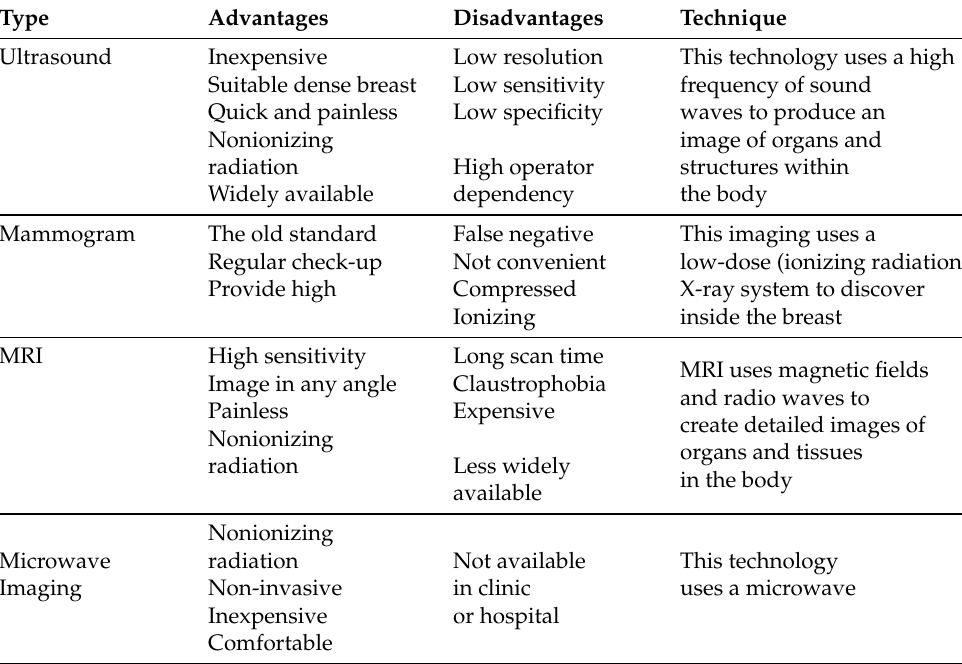
Table 3. Advantages and disadvantages of various imaging modalities in breast cancer screening